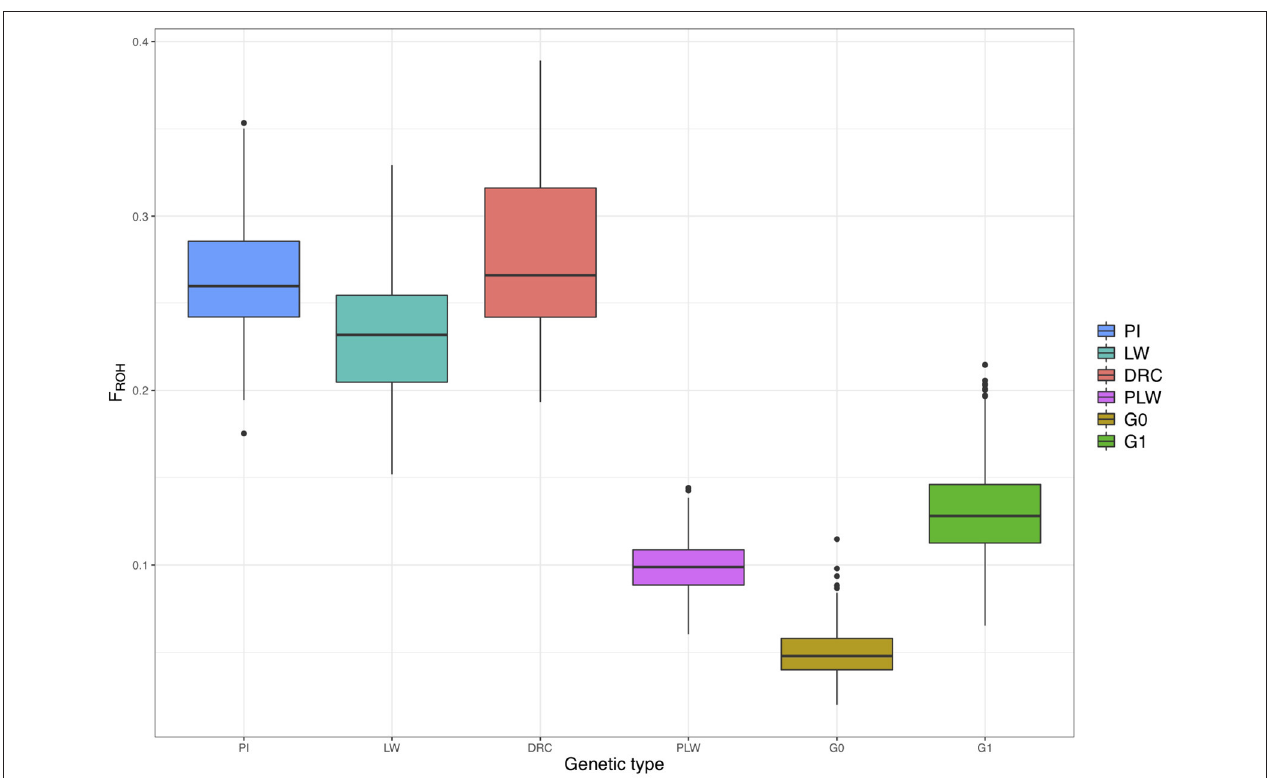
FIGURE 7 | Runs of homozygosity (ROH)-based inbreeding coefficient ( F ROH ) for each genetic type. DRC, Duroc; G0, (Pietrain × Large White) × Duroc offspring; G1, G0 × G0 offspring; LW, Large White; PI, Pietrain; PLW, Pietrain × Large